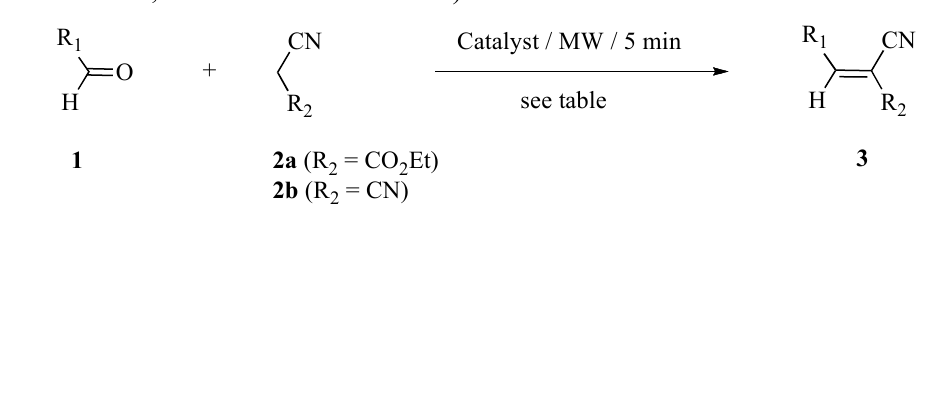
Table 1 . Knoevenagel condensation of aldehydes with ethyl cyanoacetate 2a and malonitrile 2b catalyzed by p-hydroxyapatite under solvent-free and microwave irradiation (Power = 1250 W, irradiation time = 2